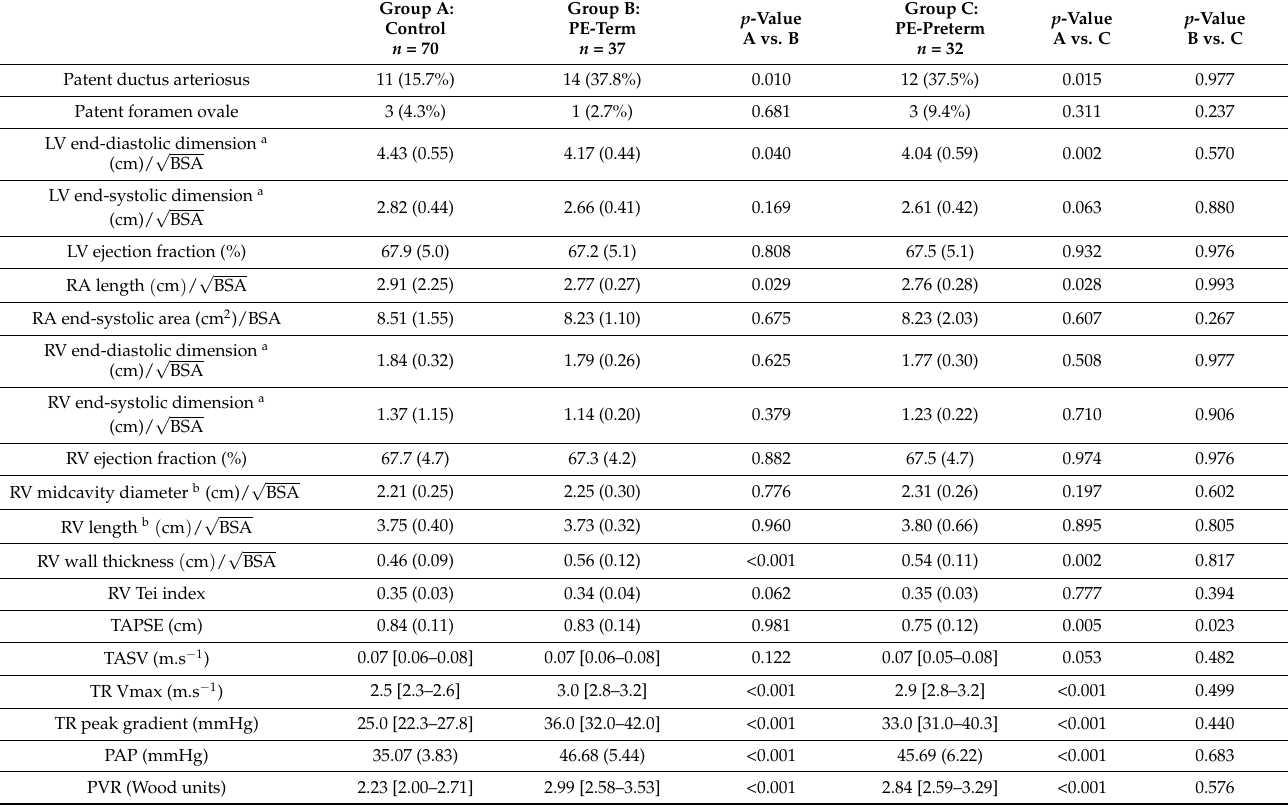
Table 2. Echocardiographic